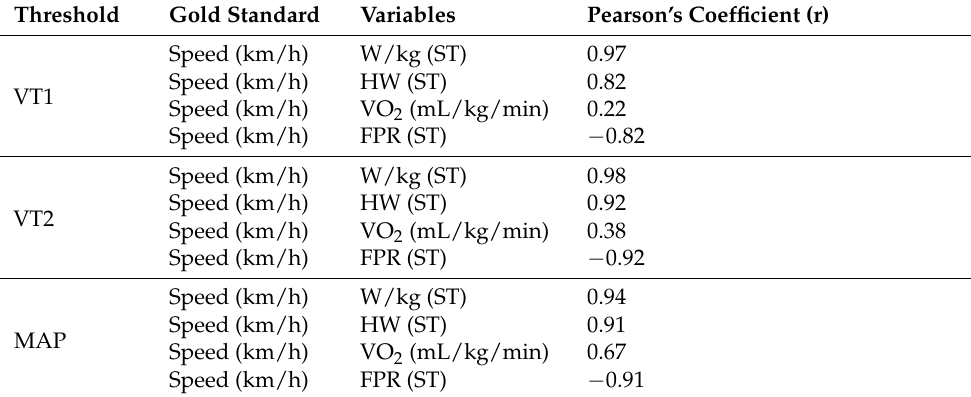
Table 2. Correlation between power per kilogram (W/kg), horizontal power (HW), and the form power ratio (FPR) with athlete speed at each running threshold, as well as between VO 2 max and the velocity at each threshold. Note: (ST) refers to the measurement made with the Stryd system. Threshold Gold Standard Variables Pearson’s Coefficient (r) Speed (km/h) W/kg (ST) VT1